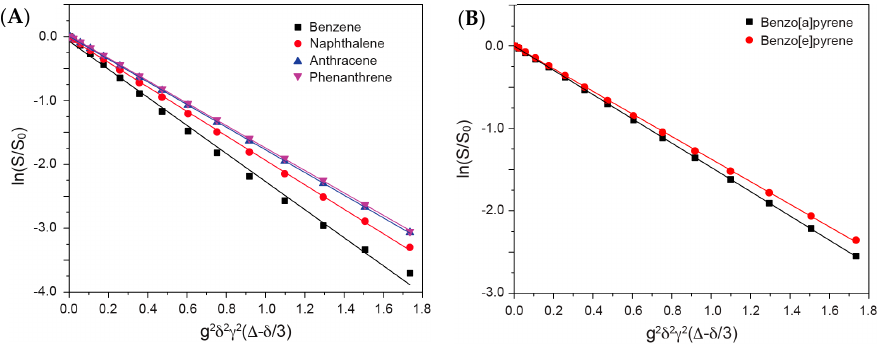
Figure 4. Stejskal-Tanner plot for each compound in Mixture A ( A ) and Mixture B ( B ).